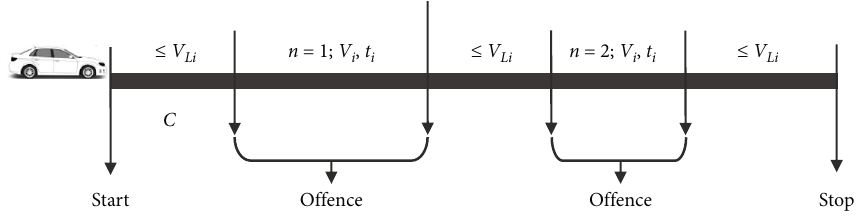
Figure 2: Schematic illustration of SLCI parameters for a trip on a section of road.